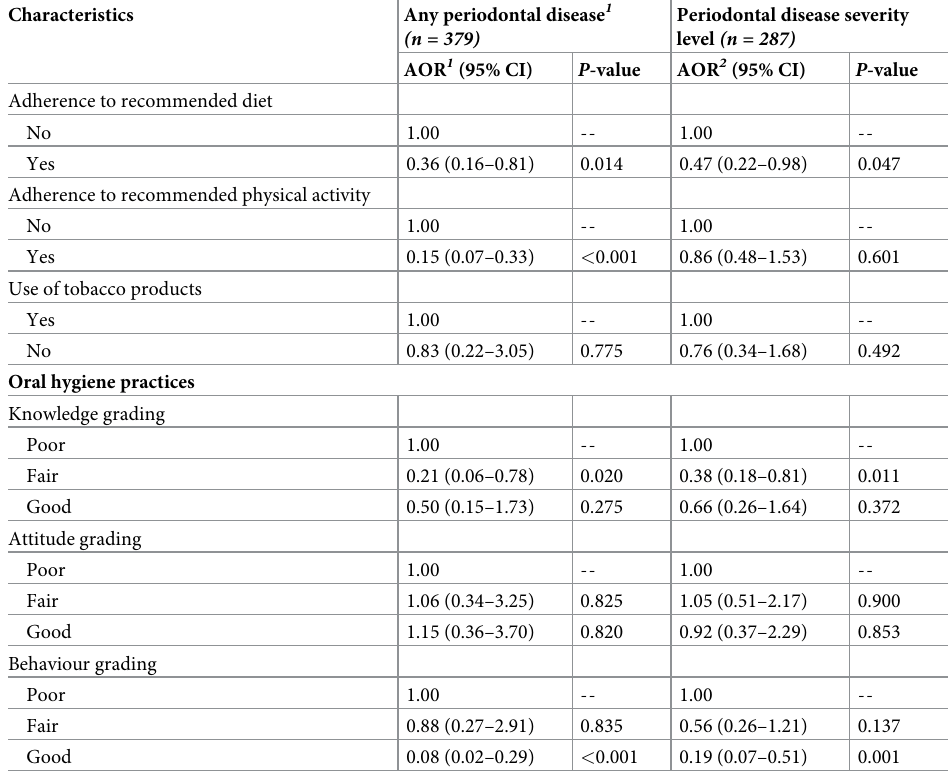
disease 2 Ordinal logistic regression analysis was run for severity of periodontal disease-diagnosed patients, namely mild, moderate and severe patients with mild disease as the reference